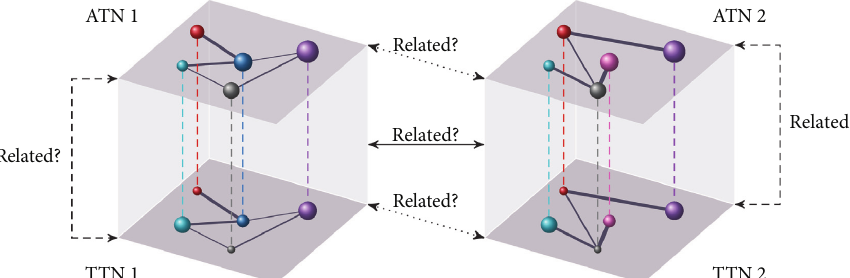
Figure 13: 3D depiction of two MTNs (left and right) each consisting of two layers (including a TTN at the bottom and an ATN at the top of the respective cube). Shared colors of nodes and dashed vertical lines indicate identically labeled vertices. The depiction disregards the orientation of the arcs. In this example, all four layers span topic networks over the same set of topics (vertices). Any such two-layer MTN can be used to represent the intertextuality- and coauthorship-based networking of the topics derived from the same corpus of texts about the same place. In this way, we gain several perspectives for the analysis of such multiplex networks: by comparing the TTNs or the ATNs of different MTNs (dotted arcs), by comparing the TTNs of different networks with their corresponding ATNs (dashed arcs), or by comparing the different MTNs as a whole with each other (solid arc).